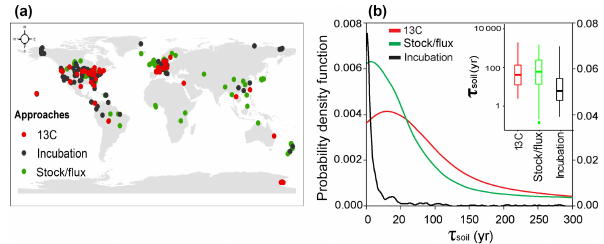
Figure 1. Spatial distributions of observational sites for estimates of SOC transit time ( τ soil , year). (a) The site locations of measure- ments with different approaches. (b) Probability density functions of τ soil measured with different approaches. Note that the left axis is for the 13 C and stock-over-flux approaches, and the right axis is for laboratory incubation